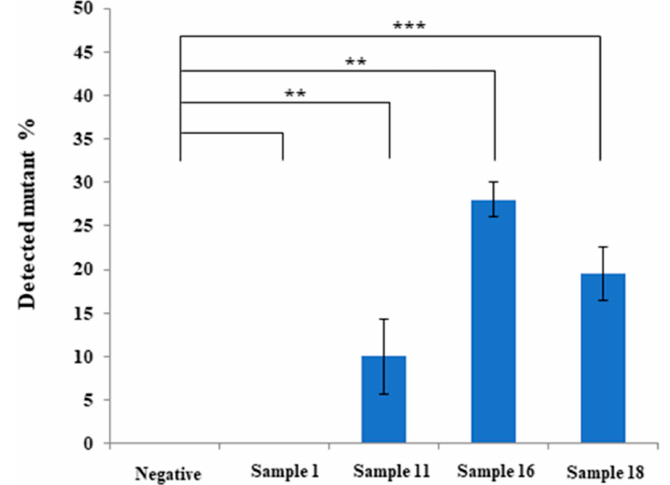
Figure 3. Representative results on the K211 somatic mutation rates of the bovine prion protein gene ( PRNP ) using pyrosequencing. Negative: standard material with 0% somatic mutation rates; Sample 1: Hanwoo, medulla oblongata; Sample 11: Holstein, medulla oblongata; Sample 16: Holstein, medulla oblongata; Sample 18: Holstein, medulla oblongata. All experiments were repeated three times. ** indicates p < 0.01 and *** indicates p < 0.001. times. ** indicates p < 0.01 and *** indicates p < Table 4. In silico evaluation of the impact of K211 somatic mutation on the bovine prion protein.